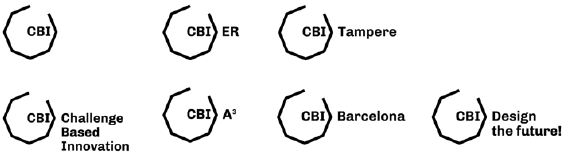
Fig. 10. Further developments of the